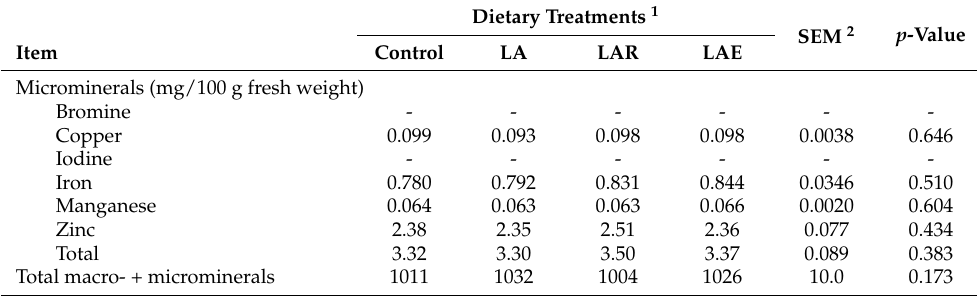
Dietary Treatments 1